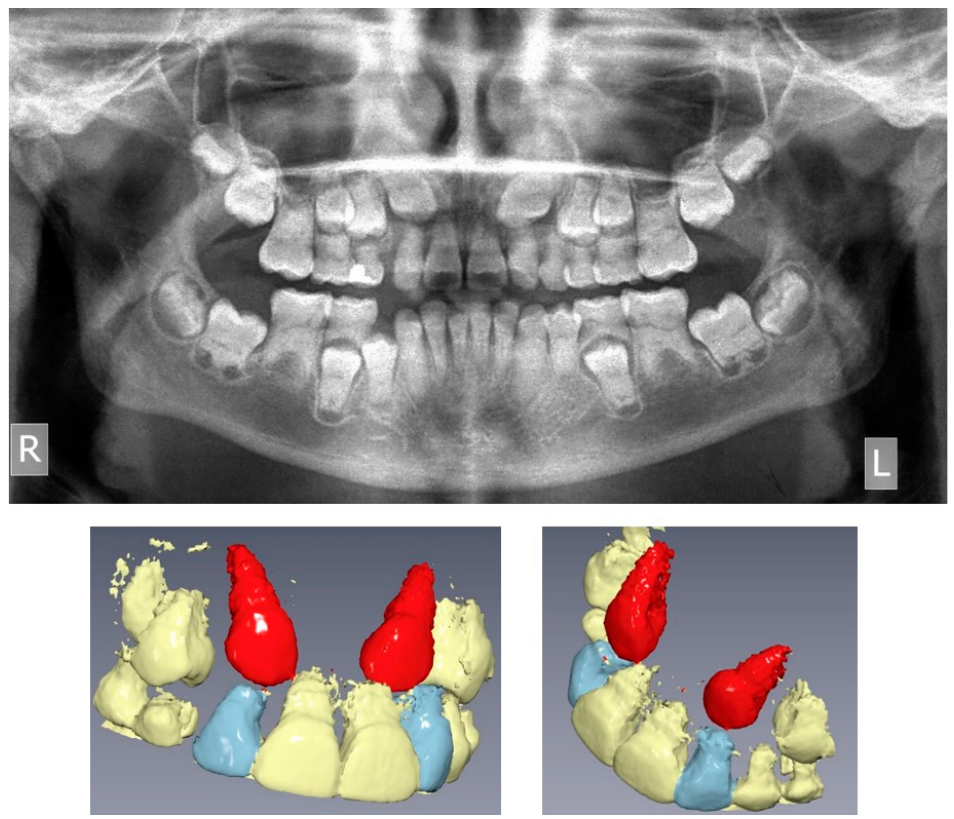
Figure 2. Pre-treatment panoramic radiograph and Cone Beam Computed Tomography 3D reconstruction of the maxilla, showing the impacted upper canines (R: right, L: left, upper canines displayed in red).